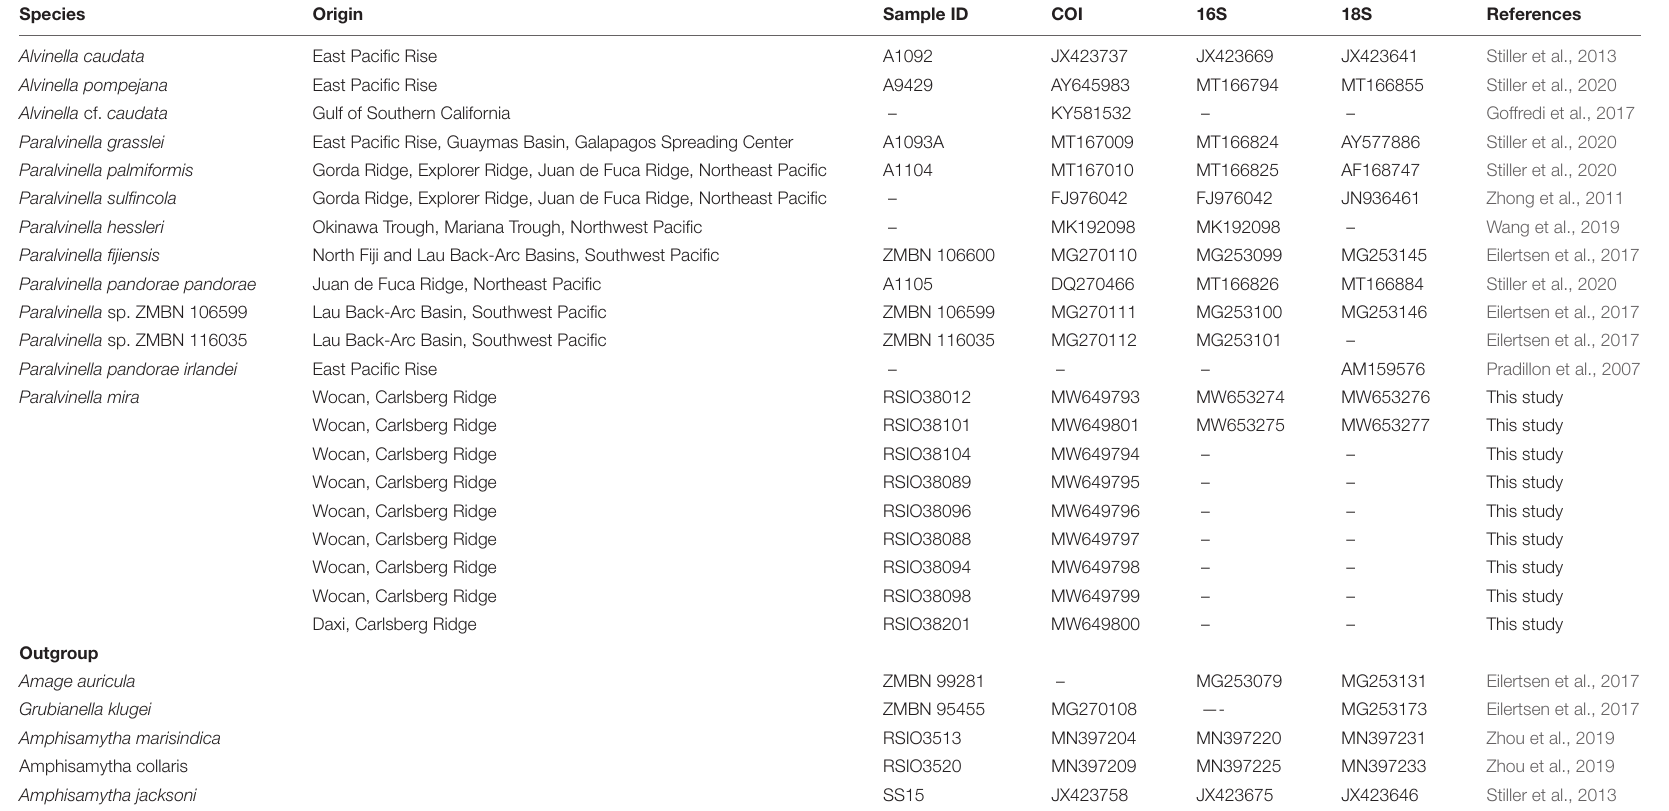
TABLE 1 | Sample and sequence information for taxa used in this